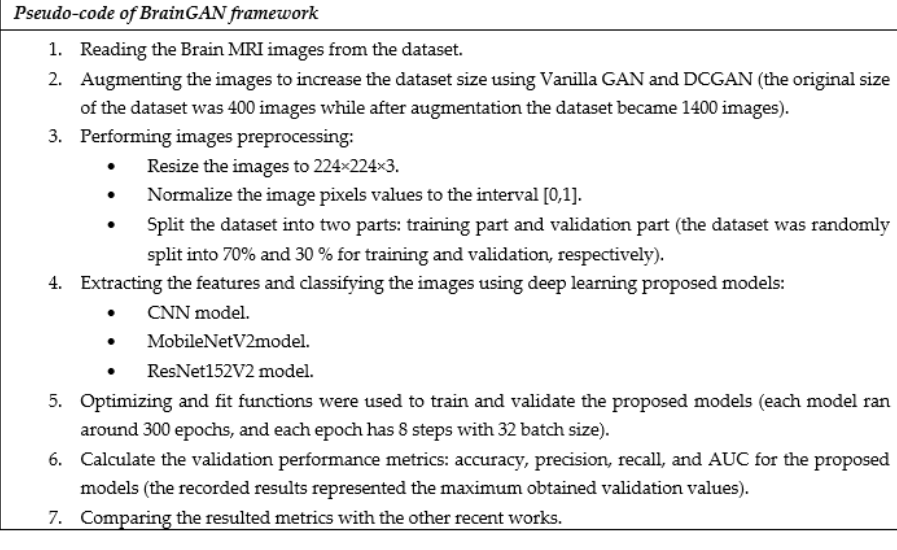
Figure 2. The Pseudo-code of the proposed BrainGAN framework